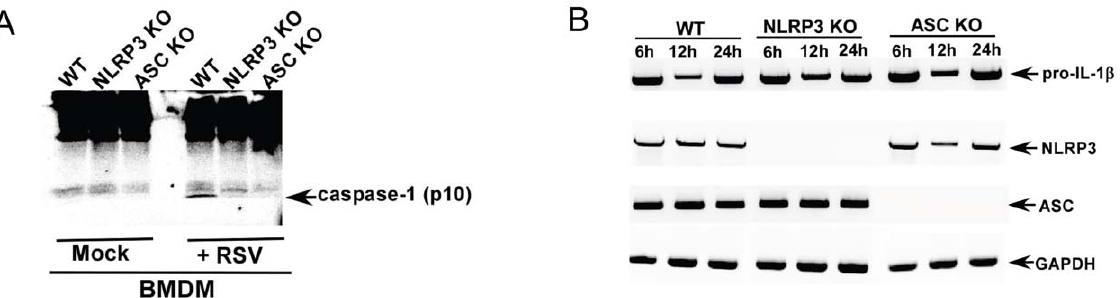
Figure 4. NLRP3 and ASC are required for caspase-1 activation following RSV infection. ( A ) Wild type (WT), NLRP3 knock-out (KO) and ASC KO BMDMs were infected with RSV (1 MOI) for 12 h. The cell lysate from mock infected and RSV infected cells were subjected to Western blot analysis with mouse caspase-1 p10 subunit specific antibody. ( B ) RT-PCR analysis of pro-IL-1 b , ASC and NLRP3 expression in RSV infected WT, NLRP3 KO and ASC KO BMDMs. The gels shown in (A) and (B) is representative of three independent experiments that yielded similar results.